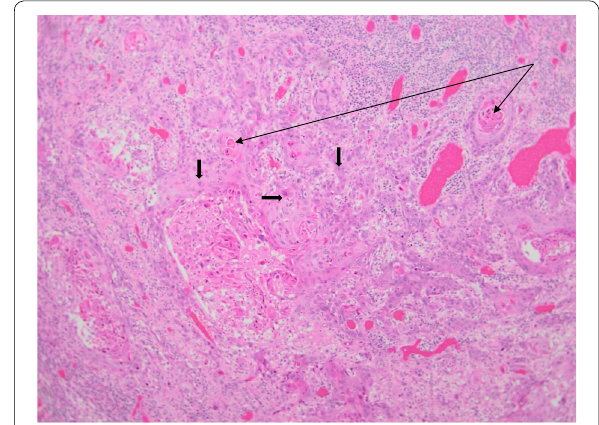
Fig. 3 Haematoxylin and eosin (H&E) photomicrograph of the patient’s tumour showing nests of pleomorphic tumour cells (three block arrows) together with keratin pearl formation (two long, thin arrows) (original magnification 200) ×